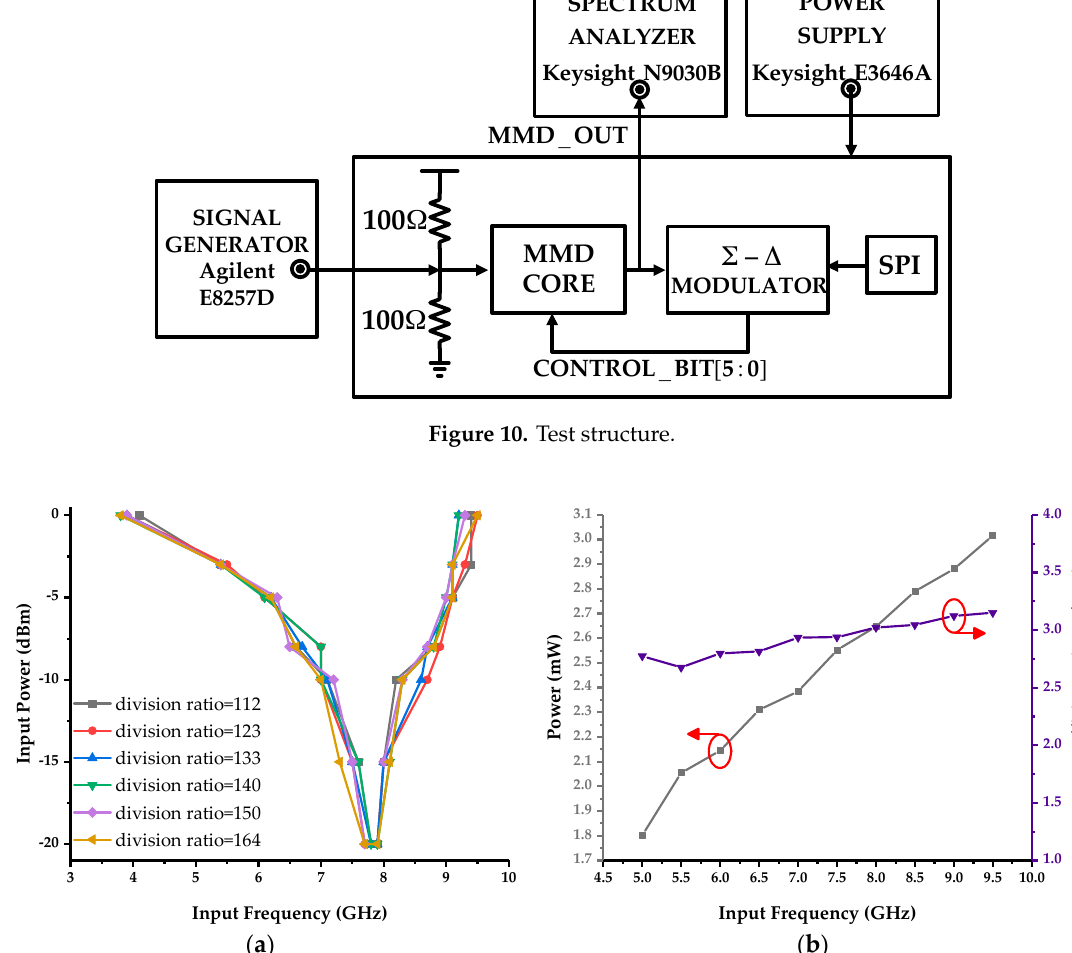
Figure 10. Test structure.